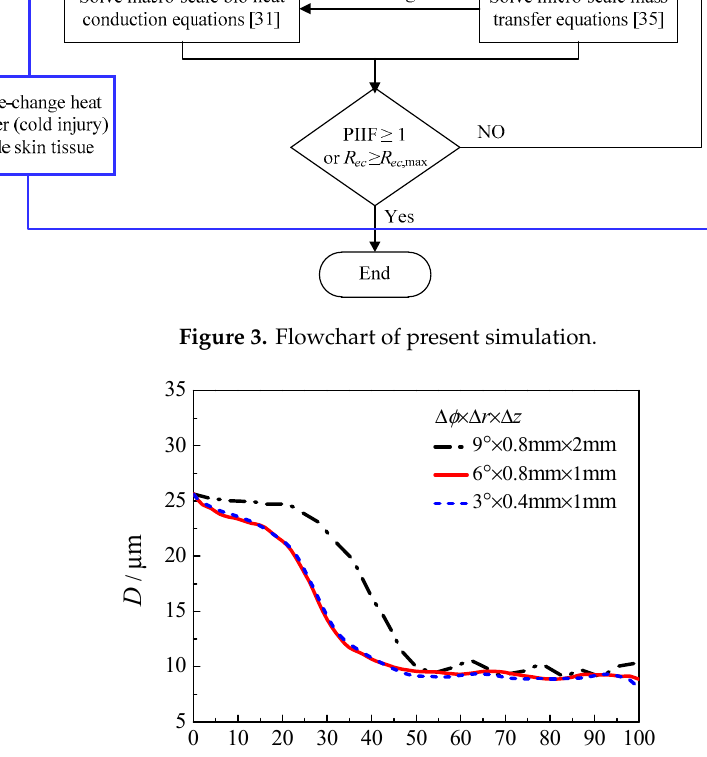
Figure 4. Axial droplet diameter distributions under different mesh sizes.